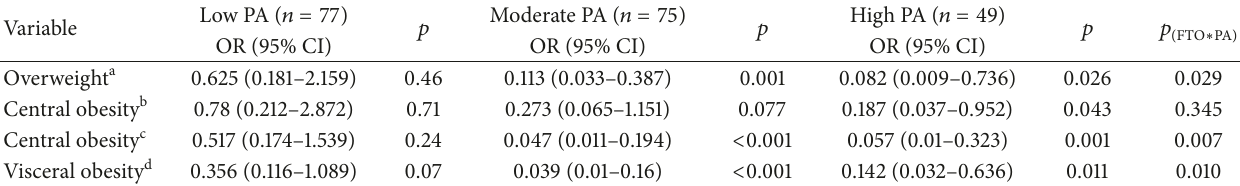
Table 4: Association between FTO rs9939609 genotype and obesity measures by category of PA.